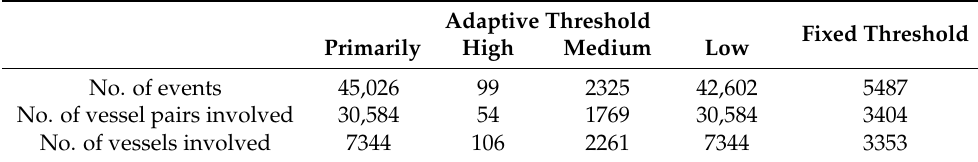
Table 11. Result comparison in Rizhao, China test dataset.